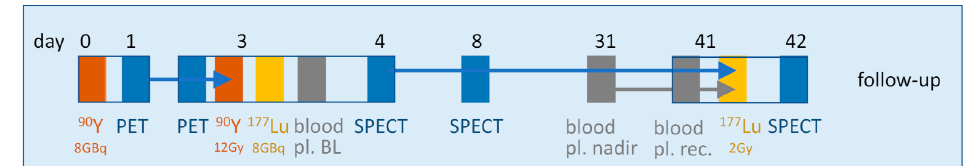
Figure 7. Proposed smart optimized tandem therapy work flow including 4 patient visits to the hospital, with one or two imagings at each